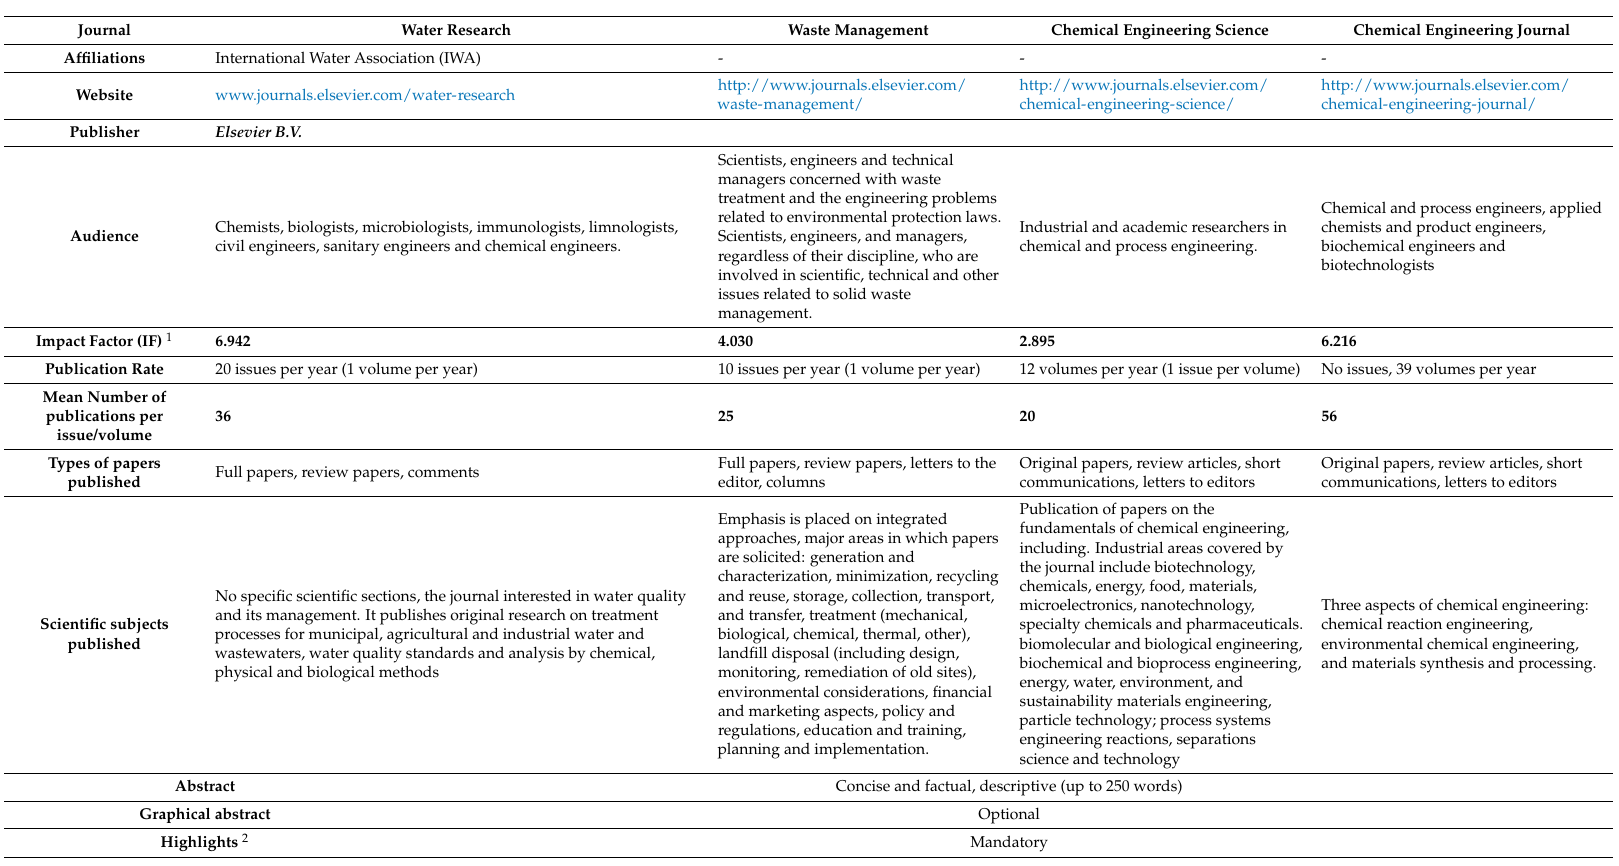
Table 1. Summary description of the scope of each journal as published on the journals’